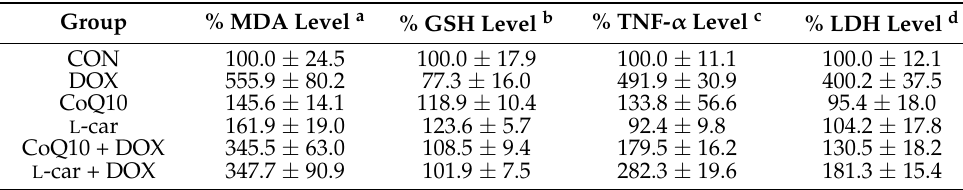
Table 16. Changes of oxidative stress parameters, inflammatory cytokine, and cardiac markers in rats due to administration of CoQ10 or L -carnitine [132].